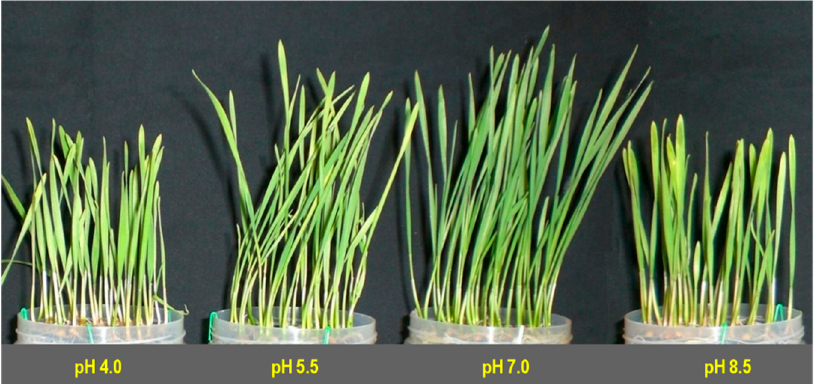
Figure 1. Visual images of morphological differences among wheat ( Triticum aestivum L. cv. BARI Gom-25) seedlings grown under different pHs.